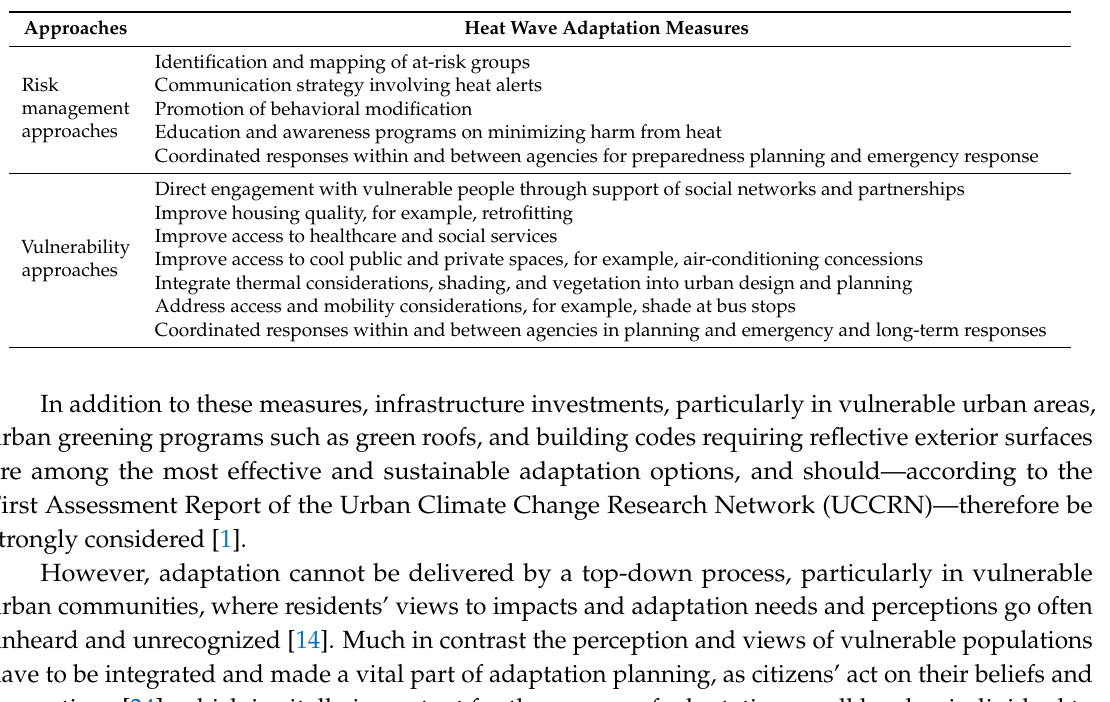
Table 1. Heat wave adaptation measures with respect to risk management and vulnerability approaches. Source: [23] (p.